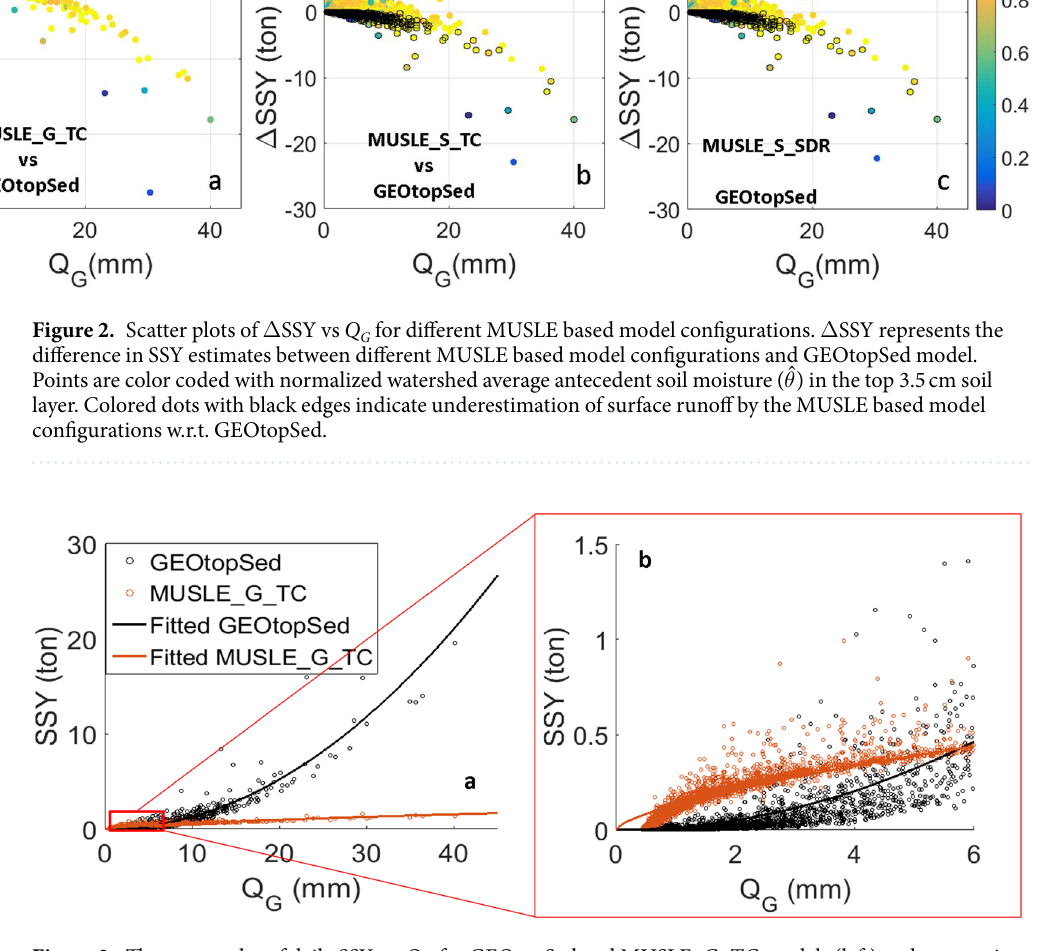
Figure 3. The scatter plot of daily SSY vs. Q G for GEOtopSed and MUSLE_G_TC models (left) and a zoom-in of the left plot for Q G < 6 mm